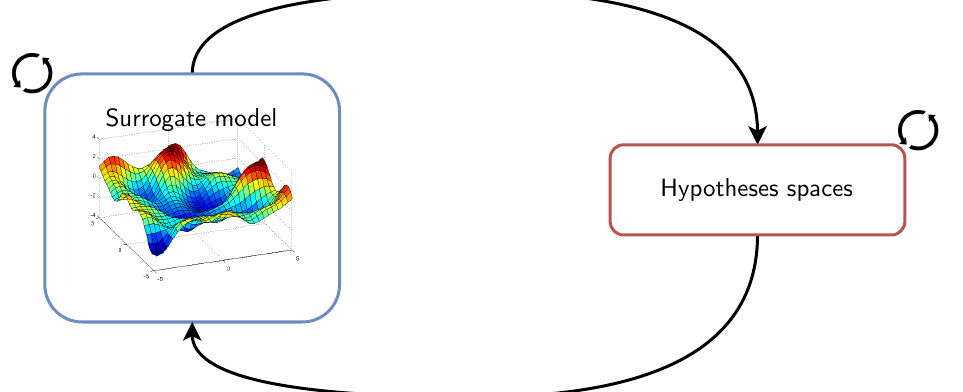
Figure 7. Framework of the proposed